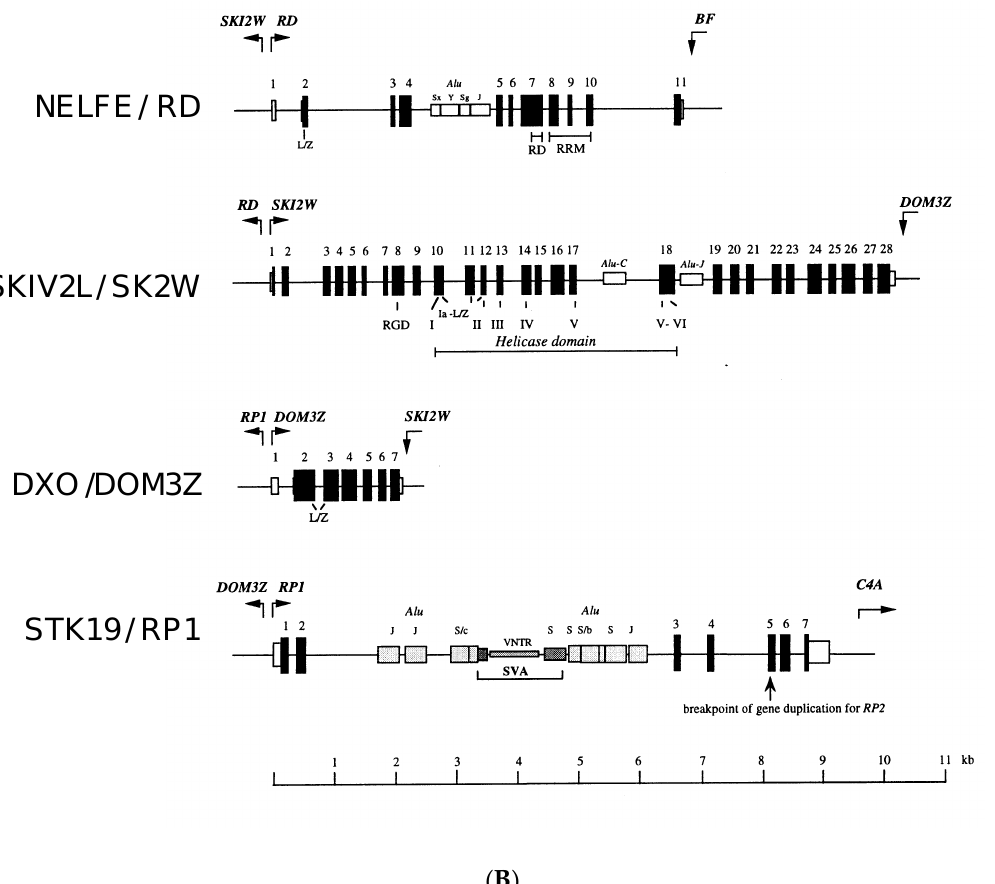
Figure 1. Map and gene structures of the NSDK (NELF-E, SKIV2L, DOX and STK19) quartet in the major histocompatibility complex (MHC) complement gene cluster. ( A ) A molecular map comparing the gene organization of human and mouse MHC complement gene cluster with RNA surveillance quartet consisting of NELF-E, SKIV2L, DXO and STK19 at the intergenic region between complement factor B and complement C4A gene. Original gene names are shown as alternatives. The mouse sequences with identities from 50–100% are plotted below the human sequences. Exons for human genes are shown as solid, purple boxes. The genomic region spanned for each gene is shaded green. The 5’ and 3’ untranslated sequences are in yellow boxes. The conserved coding sequences between human and mouse genes are highlighted in purple. Locations of CpG rich dinucleotides are shown as orange boxes. Large, repetitive retroelements SVA and endogenous retrovirus HERV-K(C4) are shown in burgundy. Arrows with solid lines represent configurations of structural genes. RP2 and TNXA are partially duplicated gene fragments. CYP21A is a pseudogene in human. Pseudogenes and gene fragments are labeled with ψ in front of gene names. Genomic DNA sequences are obtained from the following accession numbers: Human, U89335-U89337, AF019413, M59815, M59816, L26260-L26263, U07856, AF059675 and AF077974; mouse, AF030001, AF049850 and AF109906. Numberings below box represents length in human genomic DNA in kb (2k = 2 kb). The 5′ region of complement C2 gene is not well defined. Located approx. 26.4 kb upstream of the gene for C2 isoform 5 and in opposite orientation is the zinc finger and BTB domain containing protein 12 (ZBTB12). Present at the 3′ end of the C2 gene and in opposite orientation is a genetic element for long non-coding RNA (lncRNA C2-AS1, not shown). ( B ) Exon-intron structures of human NELF-E, SKIV2L, DXO and STK19 (modified from refs [15,16]).